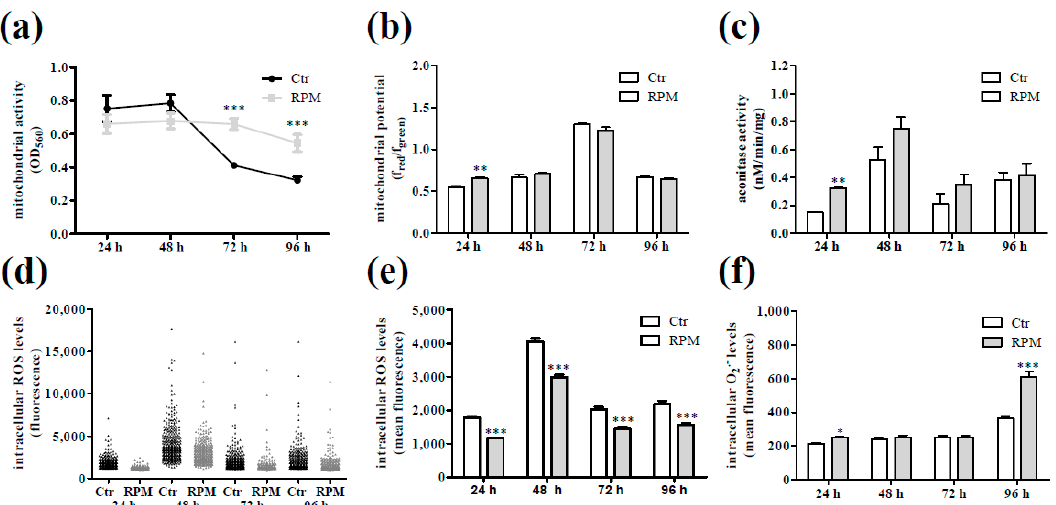
Figure 4. Oxidative status and mitochondria activity of Jurkat cells grown under standard (at 1 g, Ctr) or s-microgravity (RPM) conditions. ( a ) Mitochondria activity tested by 3-(4,5-dimethylthiazol-2-yl)-2,5-diphenyltetrazolium bromide (MTT) assay in live cells, and expressed as optical density (OD) at 560 nm. ( b ) Mitochondria membrane potential in live cells, and expressed as the ratio between red and green fluorescence at each time point. ( c ) Aconitase activity expressed as nmol / min / mg of protein. ( d ) and ( e ) Intracellular ROS levels expressed as fluorescence intensity in single cells ( d ) or mean level of intracellular ROS in cell populations expressed as fluorescence mean intensity ( e ). ( f ) O 2 -levels in cell populations expressed as mean fluorescence intensity. Values in a, b, c, e and f are presented as means ± SEM, n = 8. * p < 0.05, ** p < 0.01 and *** p < 0.001 compared with the corresponding Ctr.